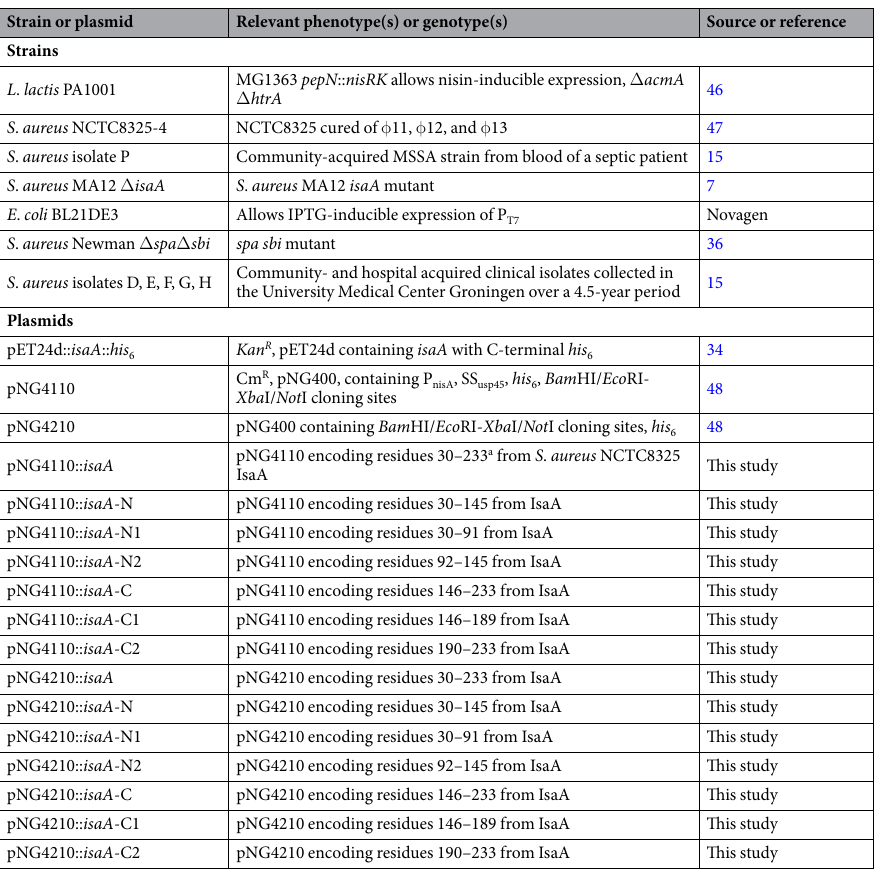
Table 1. Bacterial strains and plasmids used in this study. Kan R , kanamycin resistance gene; Cm R , chloramphenicol resistance gene; P T7 , IPTG inducible T7-promoter; P nisA , nisin inducible promoter; his 6 , 6 histidine-tag; SS usp45 , signal sequence of usp45 ; a position of amino acid residues (aa) in IsaA sequence of S. aureus NCTC8325